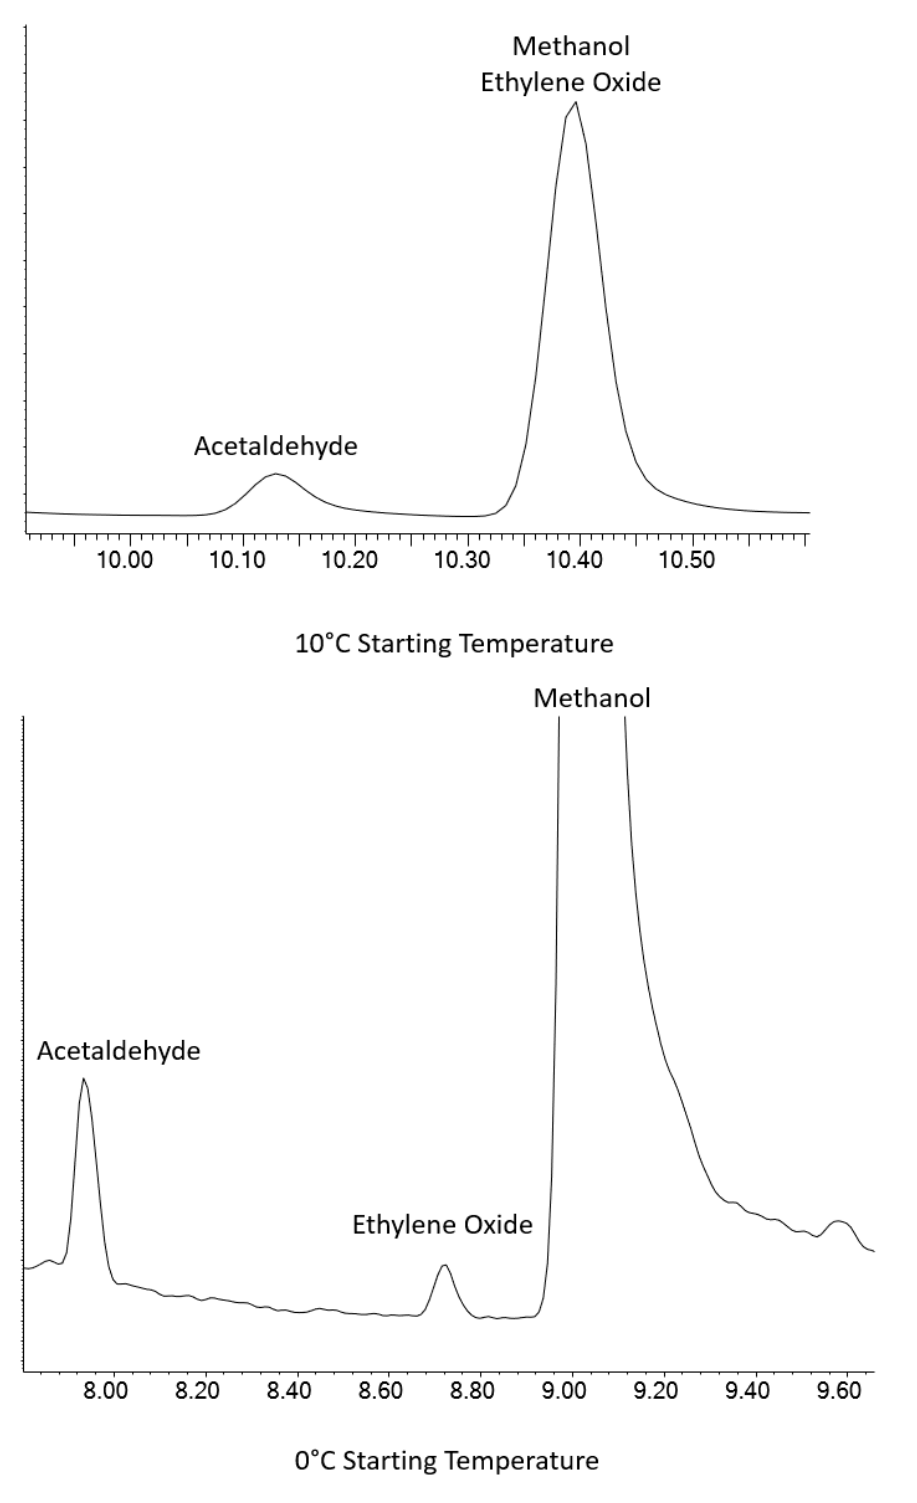
Figure 2. EtO separation from MeOH at 10 °C ( top ) and 0 °C ( bottom ) using an Rxi-624Sil MS column.